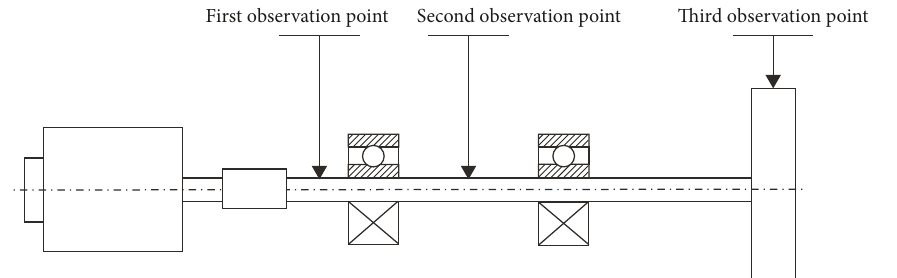
Figure 16: Distribution of test points on test stand.